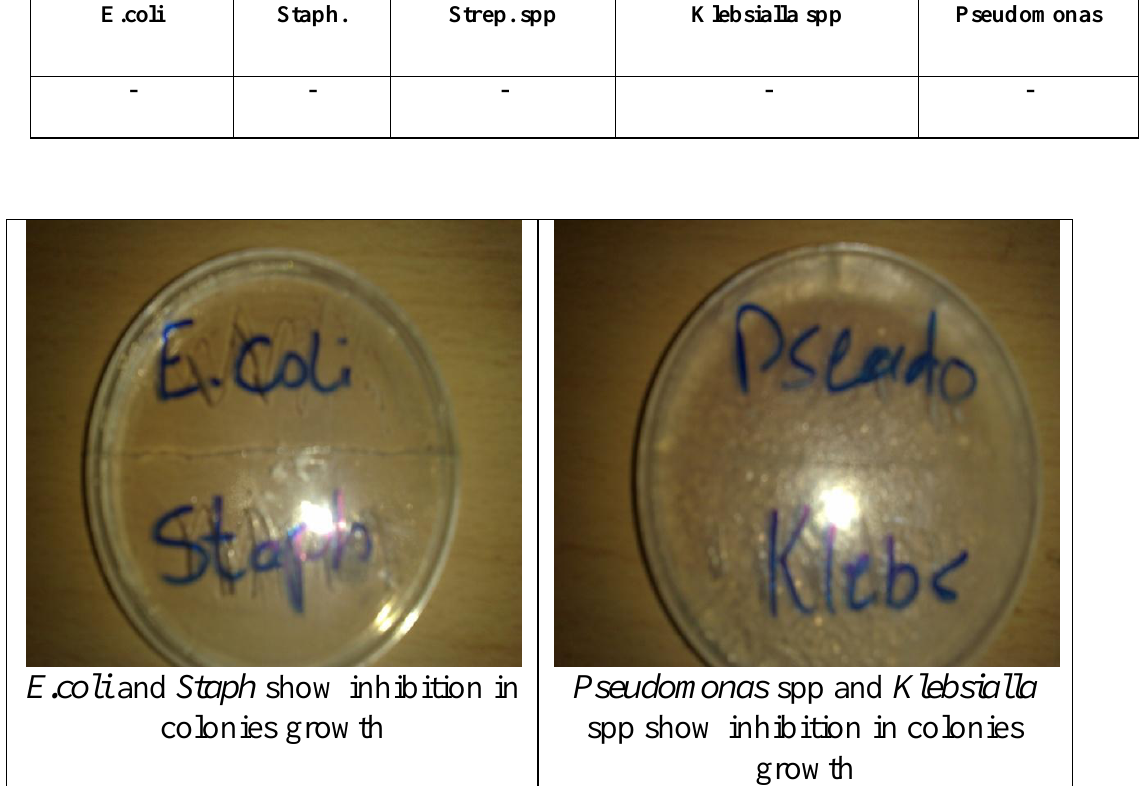
Figure (3) anti microbial dish after PMF